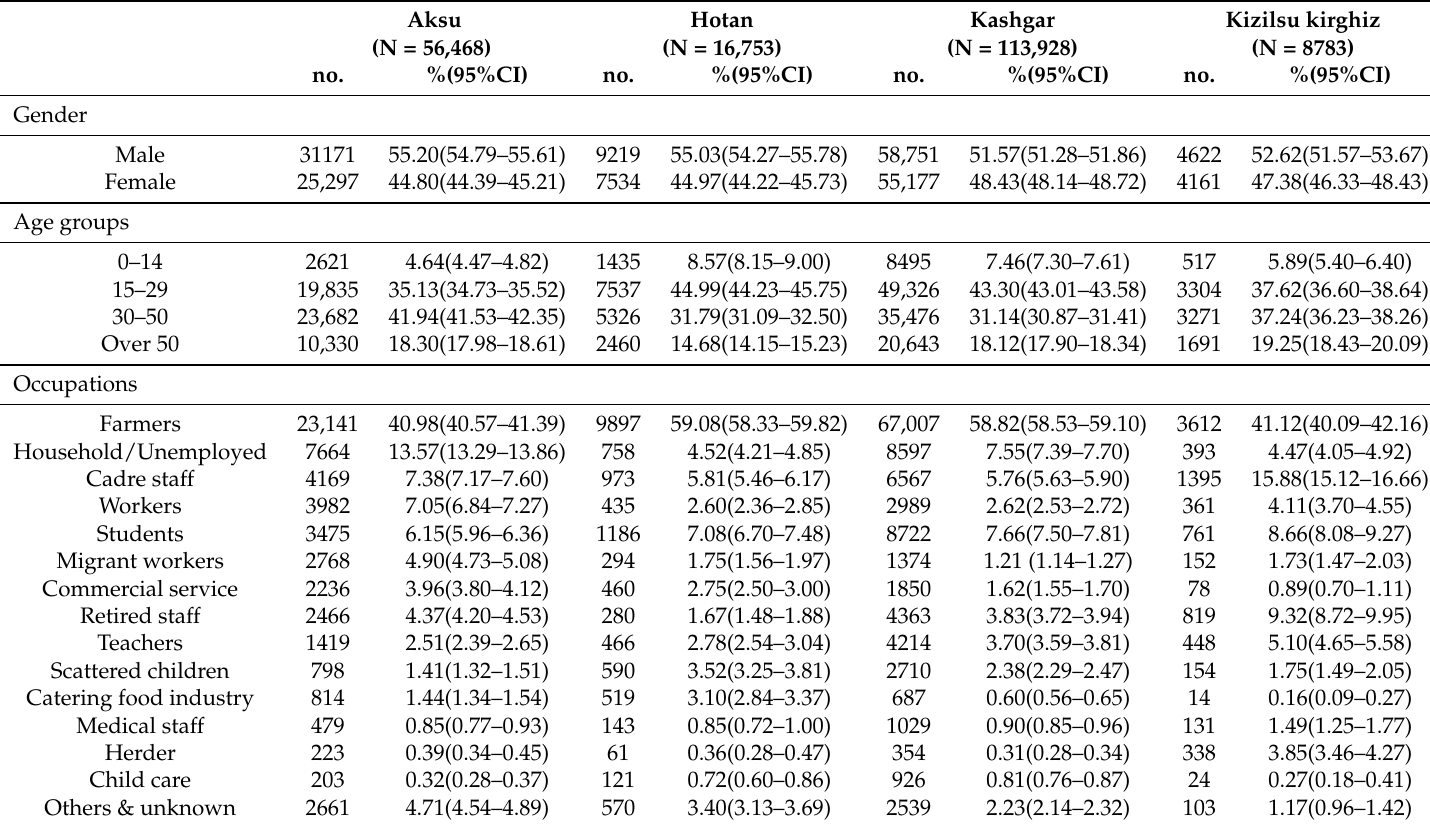
Table 1. Summary of HBV confirmations across four areas in Southern